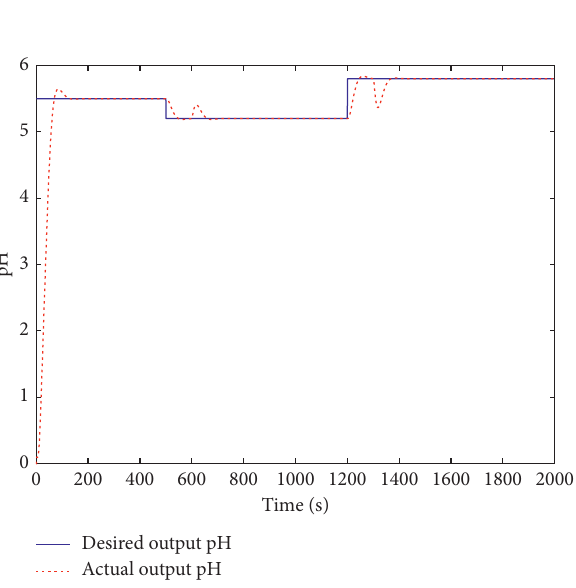
Figure 6: pH tracking curve.